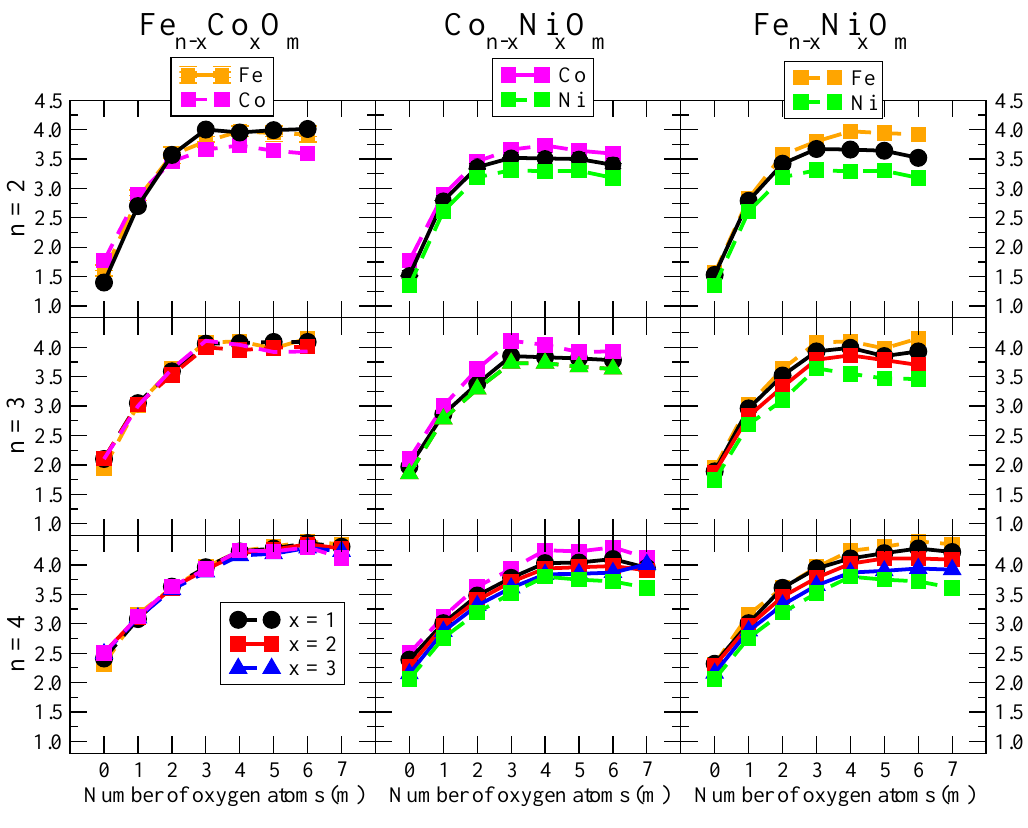
Figure 10. Binding energy per tom A n − x B x O m clusters (A, B = Fe, Co, Ni; 0 ≤ x ≤ n ; m =